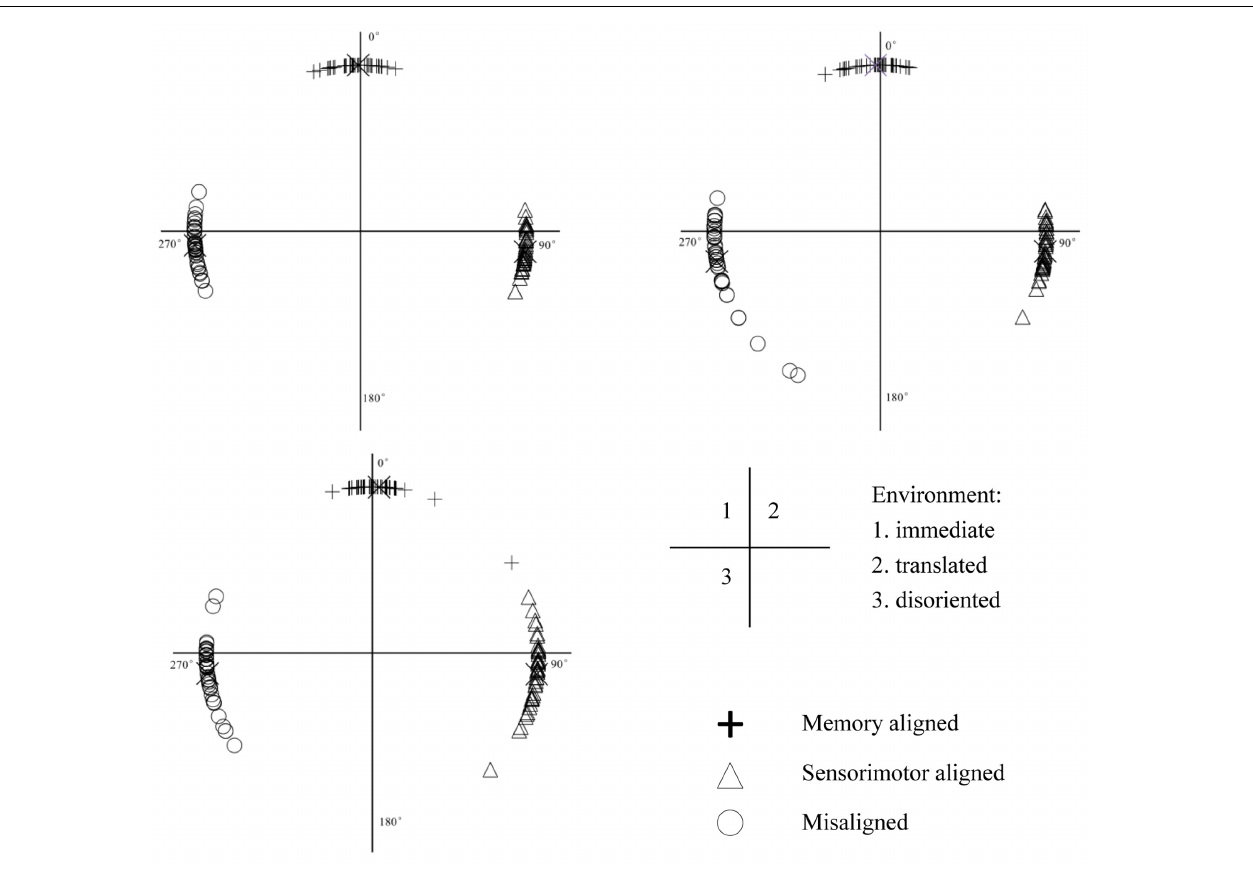
FIGURE 4 | Circular distribution of signed errors of memory aligned, sensorimotor aligned and misaligned perspectives in immediate, translated, and disoriented environments. X represents the mean signed error of each perspective. TABLE 1 | Means (standard deviations) of memory and sensorimotor aligned perspectives in different pointing directions of the three environments for both pointing latency and absolute error. Pointing latency Absolute